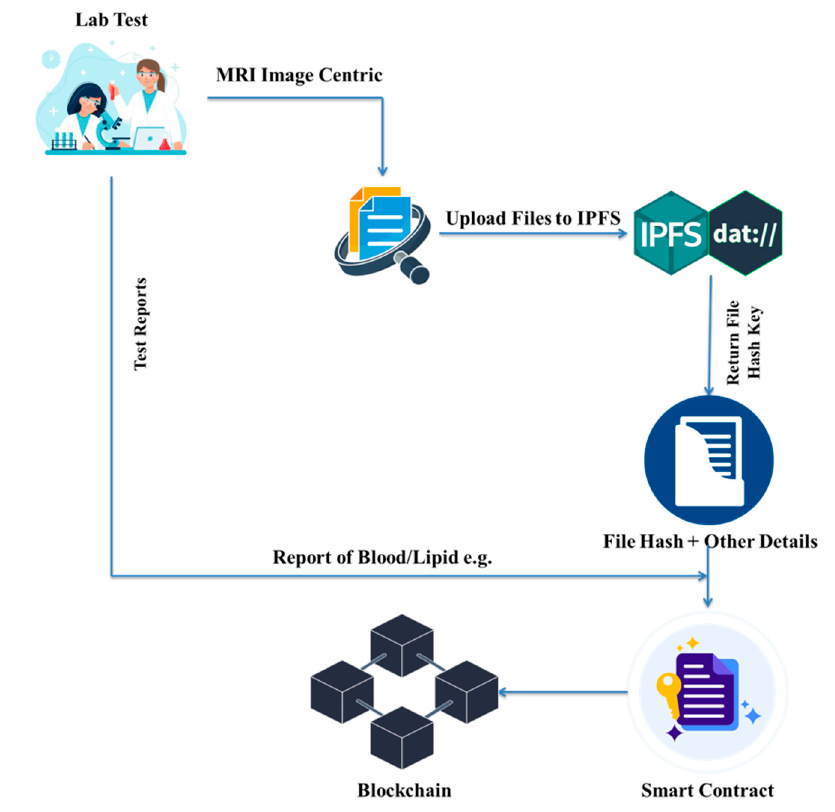
Figure 3. Data storing